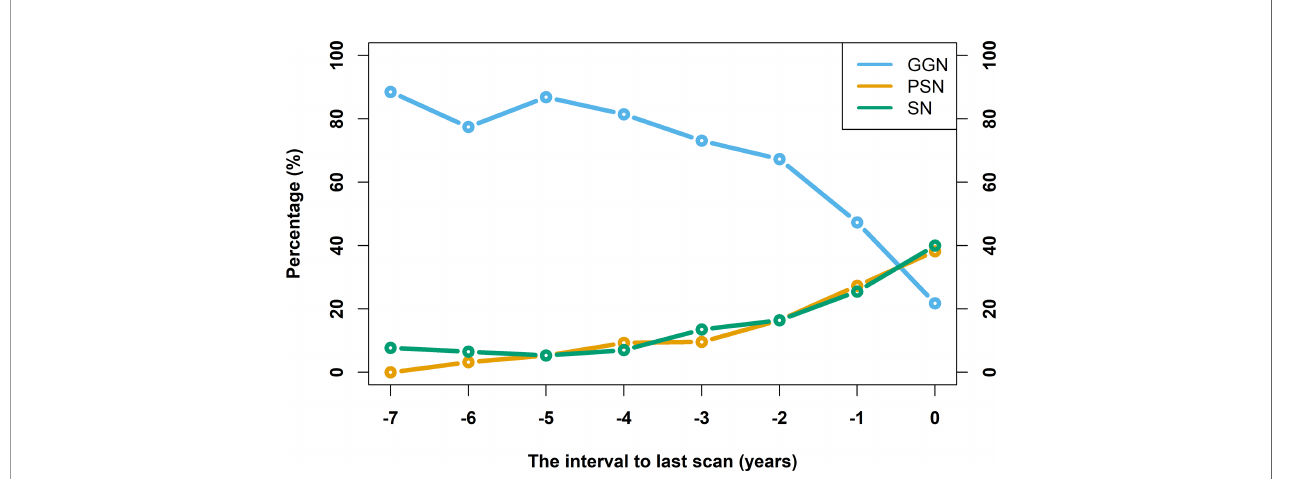
FIGURE 5 | Line chart of nodule density type percentage changes over time. The horizontal axis takes the time of con fi rmed diagnosis as zero, and the rest of the time is de fi ned relative to the time of con fi rmed diagnosis. The vertical axis indicates the percentage of density